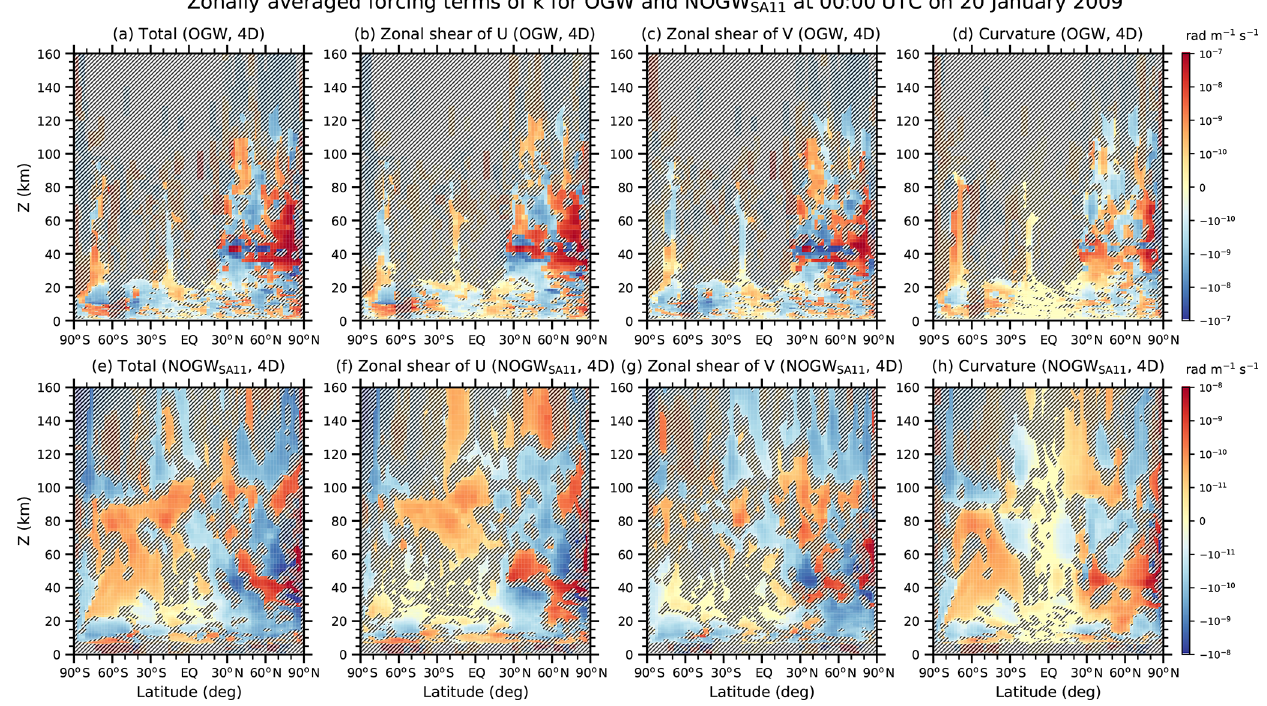
Figure 6. Latitude–height cross sections of total and three major forcing terms – the zonal shear terms of the large-scale zonal and meridional winds ( U and V ) and the curvature term – of the zonal wave number for (top row) OGW and (bottom row) NOGW SA11 in the 4D experiment at 00:00UTC on 20 January 2009. The zonal shear terms of U and V are − k/(a cos φ)∂U/∂λ and − l/(a cos φ)∂V/∂λ , respectively. The curvature term is given by lc g λ tan φ/a . Hatched areas indicate regions where the paired and two-tailed t test for the 4D and 2D experiments gives p values larger than 0.05 (i.e., no statistical significance at the level of